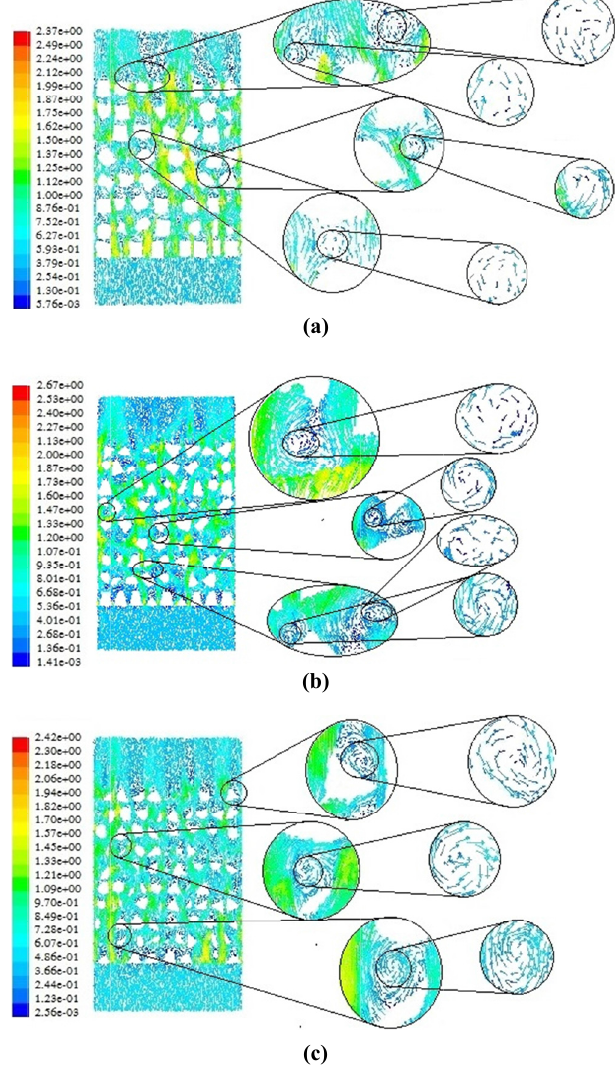
Fig. 4. Velocity vectors in the packed beds with V b =94.9 ×10 5 mm 3 and V f = 0.5 m/s: a) cylindrical particles, b) truncated cone particles, and c) cone